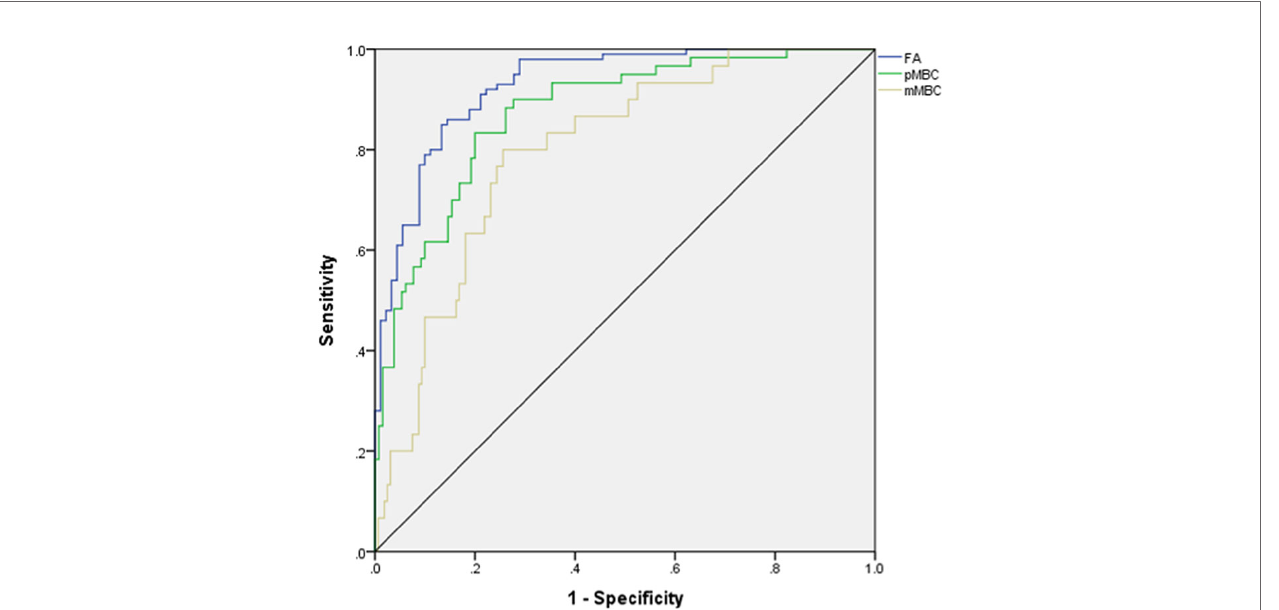
FIGURE 3 | ROC for differentiating mucinous breast carcinoma or subtypes from fi broadenoma. ROC, receiver operating characteristic curve; AUC, area under curve; FA, fi broadenoma; MBC, mucinous breast carcinoma; pMBC, pure mucinous breast carcinoma; mMBC, mixed mucinous breast